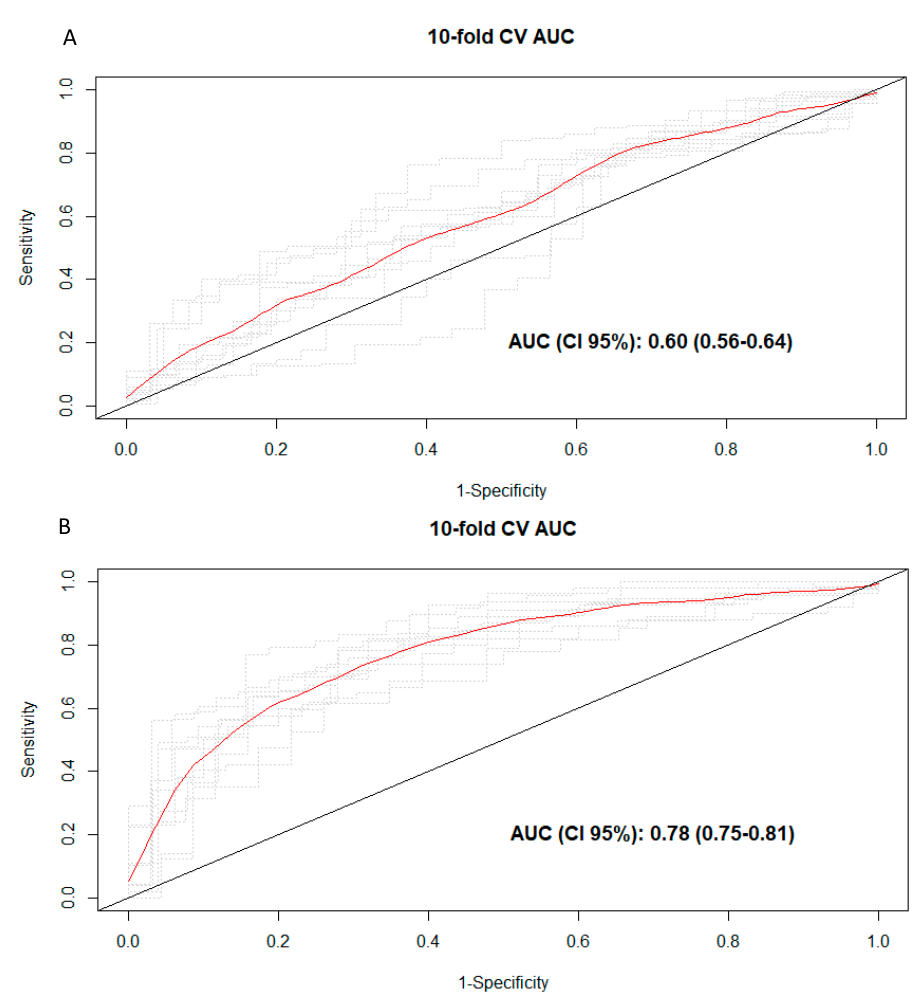
Figure 2. ( A ) Cross-validated receiver operating characteristic (ROC) curves for total coffee consumption. ( B ) en-fold cross-validated ROC curves for caffeinated coffee consumption. Red curve represent the 10-fold CV ROC curve, whereas dotted lines show ROC curves for each of the 10 iterations using the training-validation (90–10%) pair datasets.